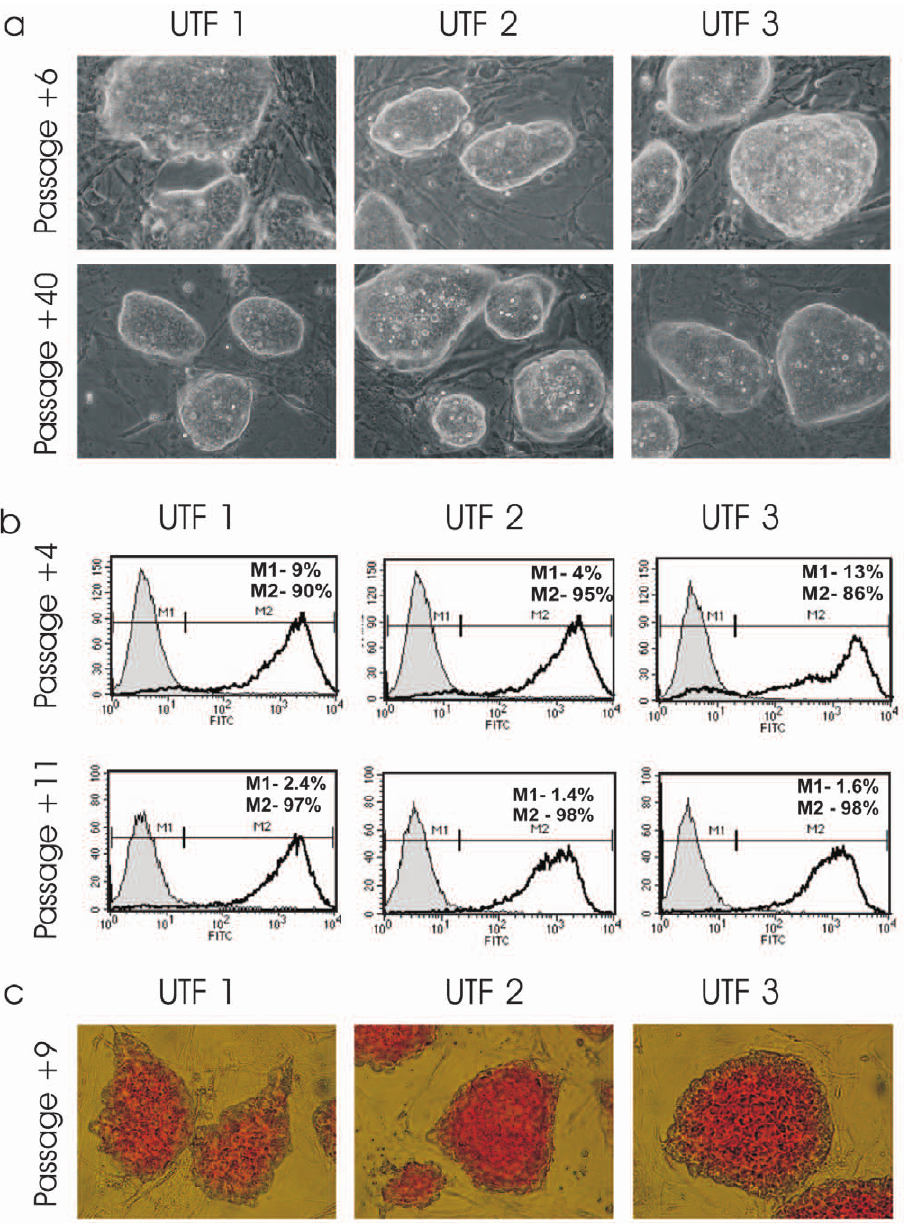
Figure 2. Characterization of three individual, UTF1-Neo selected iPS cell clones UTF-1, -2 and -3 derived from TiB7-4 cells. a ) Morphology of UTF-Neo selected iPS cells six and forty passages after transfection. Selection with G418 was performed only until initial isolation of colonies. b ) Expression of SSEA1 of UTF-1, -2 and –3 as indicated by flow cytometry four and eleven passages after transfection. c ) Alkaline Phosphatase staining of UTF-1, -2 and